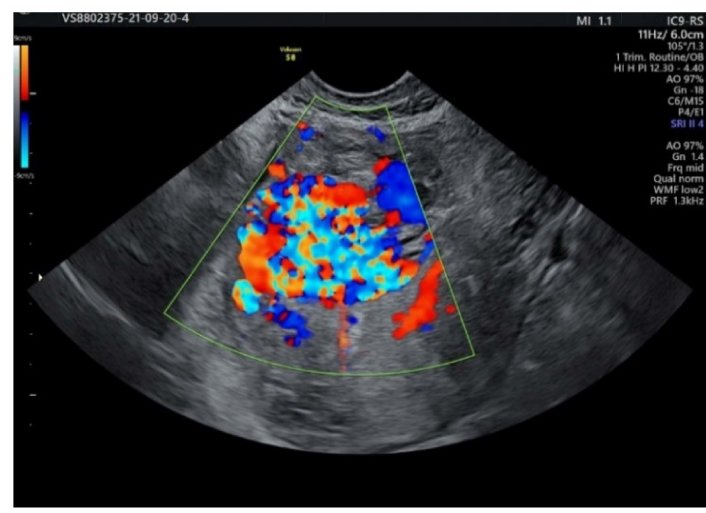
Figure 2. Uterine vascularization with mixed vascular Doppler signal. Pulsatile Doppler specified the hemodynamic characteristics of the arteriovenous shunt, as well as the alternation between predominantly systolic arterial flow and venous diastolic flow (Figure 3a,b).